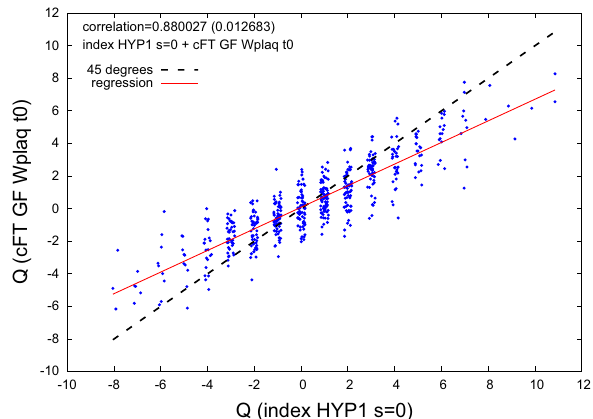
Fig. 7 Scatterplot of the topological charge for one representative fermionic definition (index of the overlap operator evaluated on config- urations with 1 step of HYP smearing applied) and one representative gluonic definition (Wilson flow at flow time t 0 ). For better visibility, the integervaluesoftheindexwererandomlyshiftedbyasmallnon-integer value